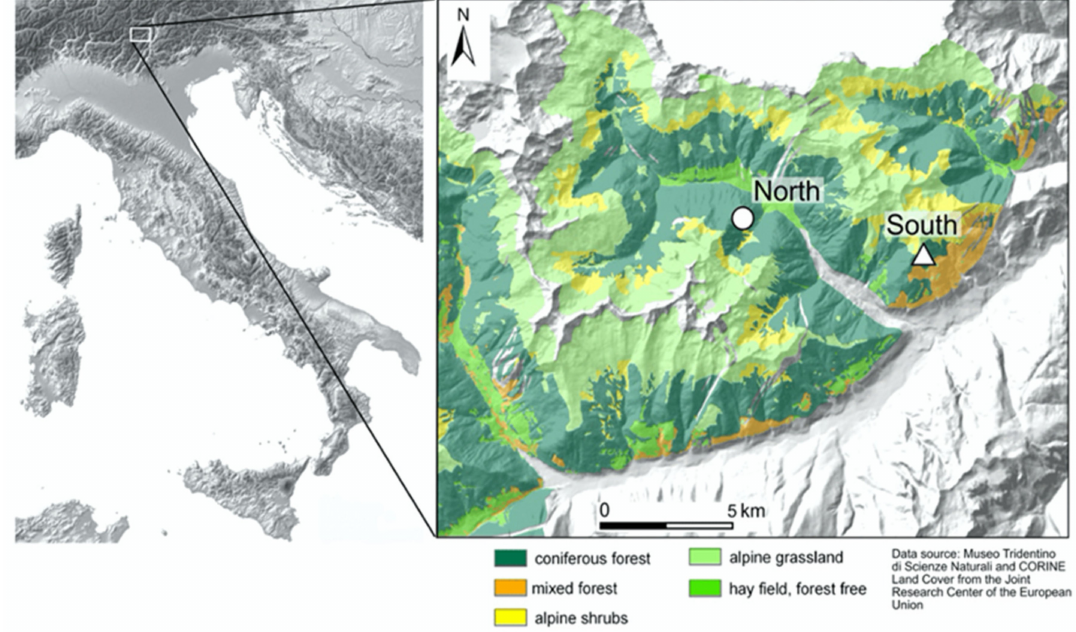
Figure 1. Overview of the study area (Trentino Alto Adige, Italy)